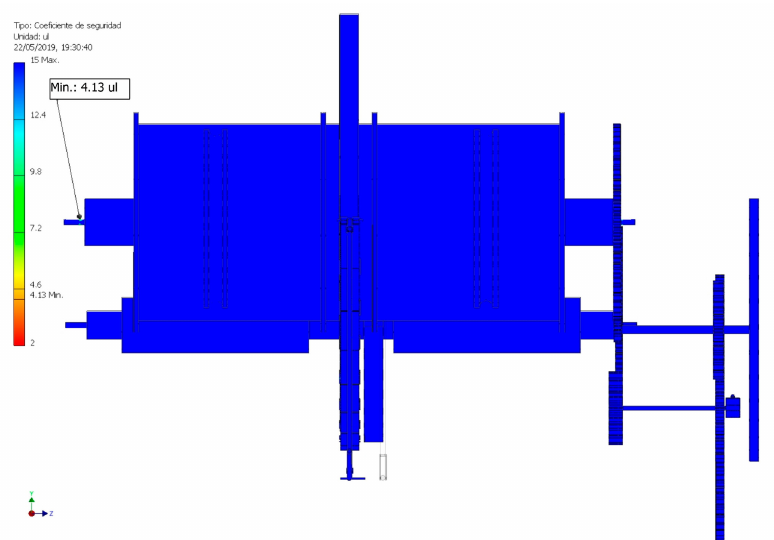
Figure 23. Third lowest safety coe ffi cient in the blockage situation.